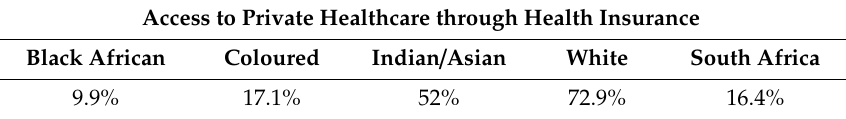
Table 1. Access to private healthcare through health